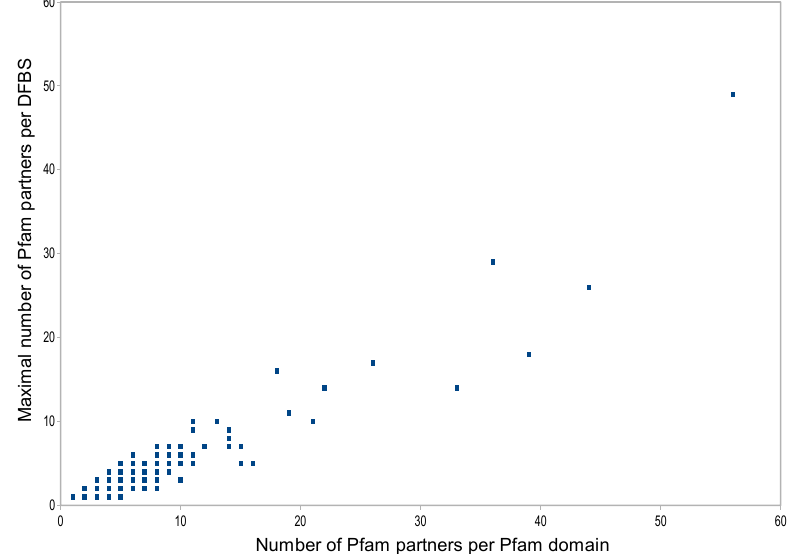
Figure 5. Scatter plot of Pfam domains according to their number of partners ( x coordinate) and the maximal number of partners per DFBS among the DFBSs they harbour ( y coordinate). For low values, one dot can represent more than one Pfam